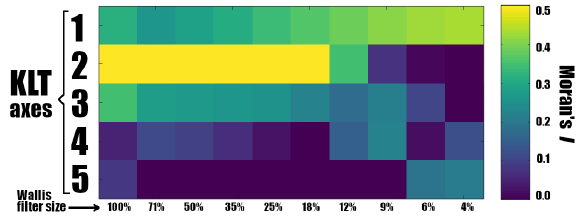
Figure 10. Evolution of Moran’s I for different Wallis filter